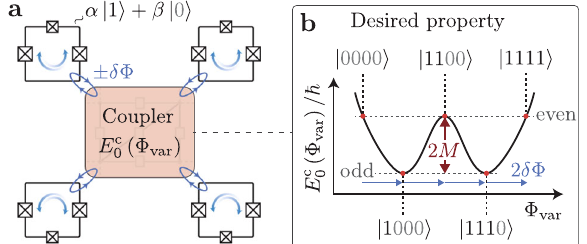
Fig. 3 Coupler spectral property enabling 4-local interaction. a Four superconducting fl ux qubits are coupled mutually inductively to a shared coupler circuit. The states 0 j i , 1 j i of each qubit are determined by the direction of the persistent circulating current in the qubit loop. By mutual induction, the magnetic fi eld generated by the qubit ’ s persistent current adds a small fl ux offset ± δ Φ to the coupler circuit. b The coupler has a ground-state energy E c that depends on an external fl ux Φ var . If this energy spectrum follows a double-well shape with spacing 2 δ Φ as indicated in the fi gure, the 4-qubit states with even and odd excitation numbers separate into two energy manifolds and the coupler mediates an effective 4-local interaction term. The challenge is to fi nd a robust coupler circuit with such a double-well spectrum. The behavior of the coupler energy over a small external fl ux range should not be confused with the inductive double-well potential of the fl ux